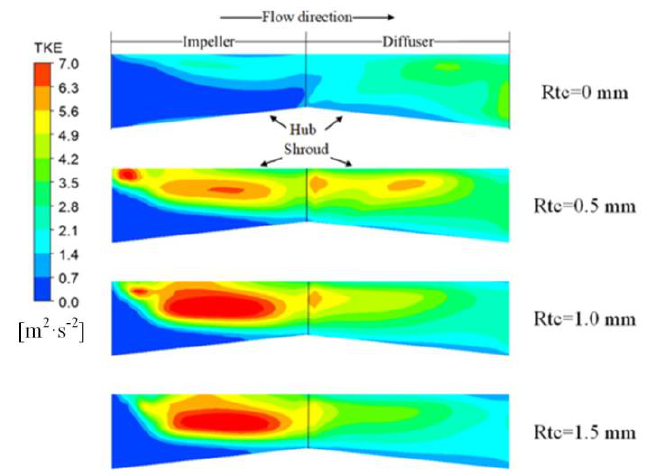
Figure 13. Turbulent kinetic energy on the impeller and diffuser meridional plane.5.7. TLV Char- acteristics .